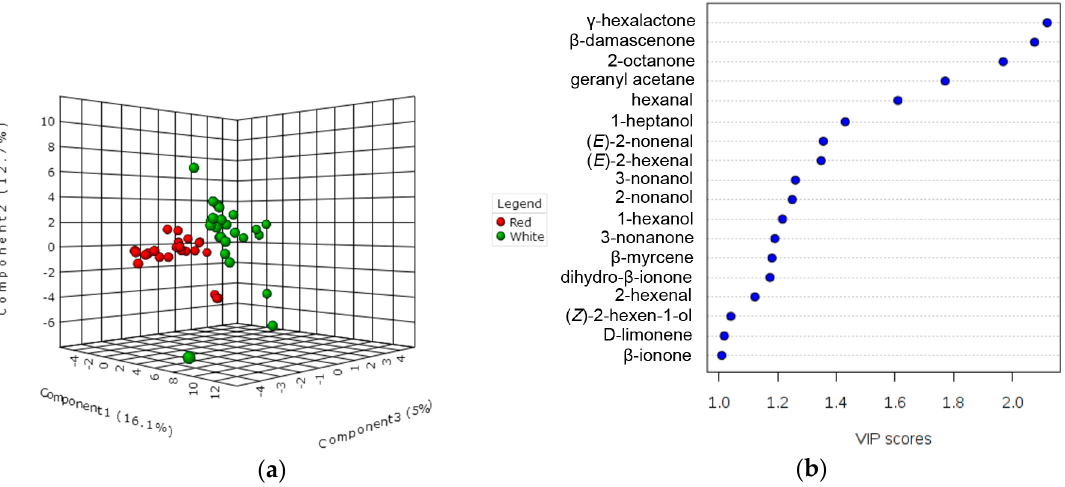
Figure 4. Multivariate analysis of peach fruit volatile compounds measured by GC-MS. ( a ) PLS-DA score plot, ( b ) volatiles ranked by VIP scores (blue dots).